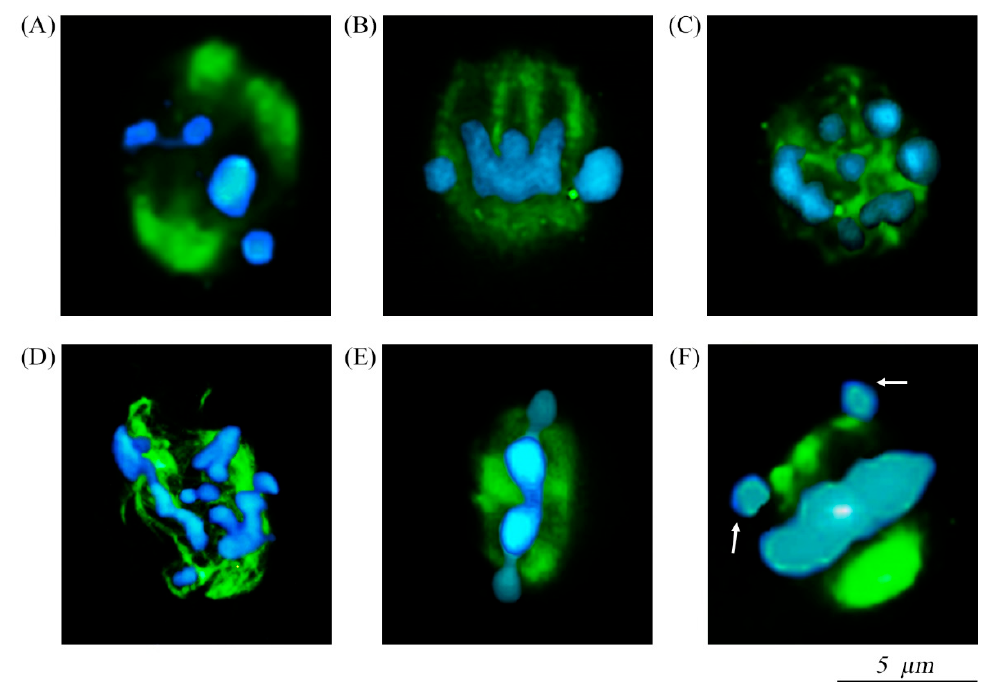
Figure 2. Confocal micrographs of spindle chromosome complexes. Anti- α / β -tubulin antibody and Alexa Fluor 488 to visualize the spindle (green) and DAPI to stain the chromosomes (blue). ( A , B ) Normal barrel-shaped spindle configuration with chromosomes arranged at the equator of the structure. ( C ) Normal spindle complex oriented perpendicular to the focal plane and chromosomes arranged in a circular way. ( D ) Spindle showing completely disorganized appearance with abnormal chromosomes configuration. ( E ) Spindle complex displaying reduction in the longitudinal dimension of the spindle and compact metaphase plate. ( F ) Normal spindle conformation with some chromosomes slightly displaced from the plane of the metaphase plate (arrows).